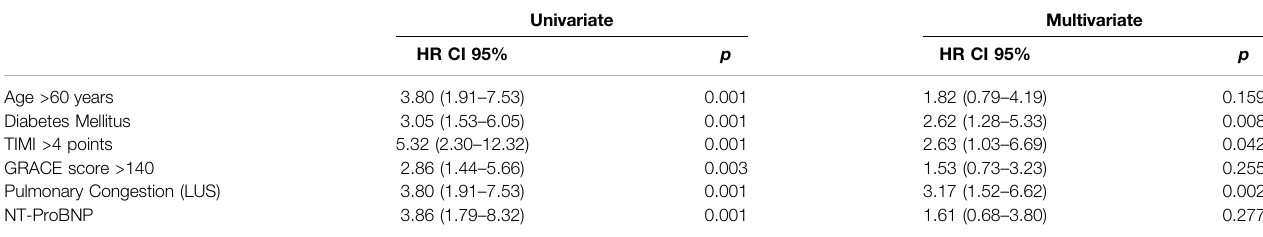
TABLE 3 | Predictors of the primary outcome in Cox regression